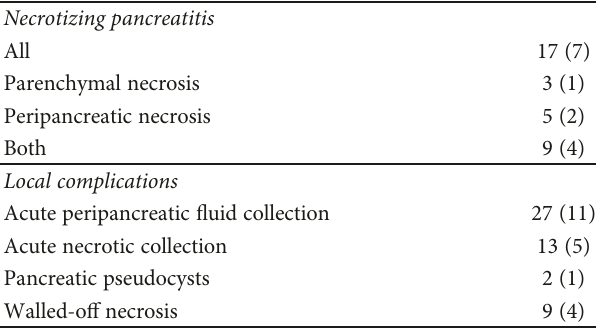
Table 4: Necrotizing pancreatitis and local complications of acute pancreatitis.